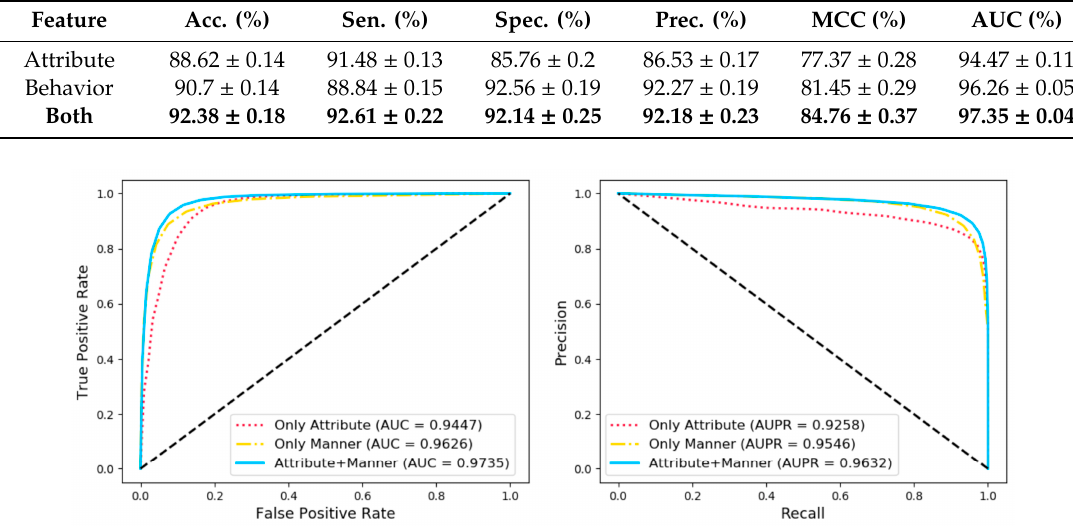
ff erent features under five-fold cross Figure 5. Comparison with different features under five-fold cross validation. Figure 5. Comparison with di